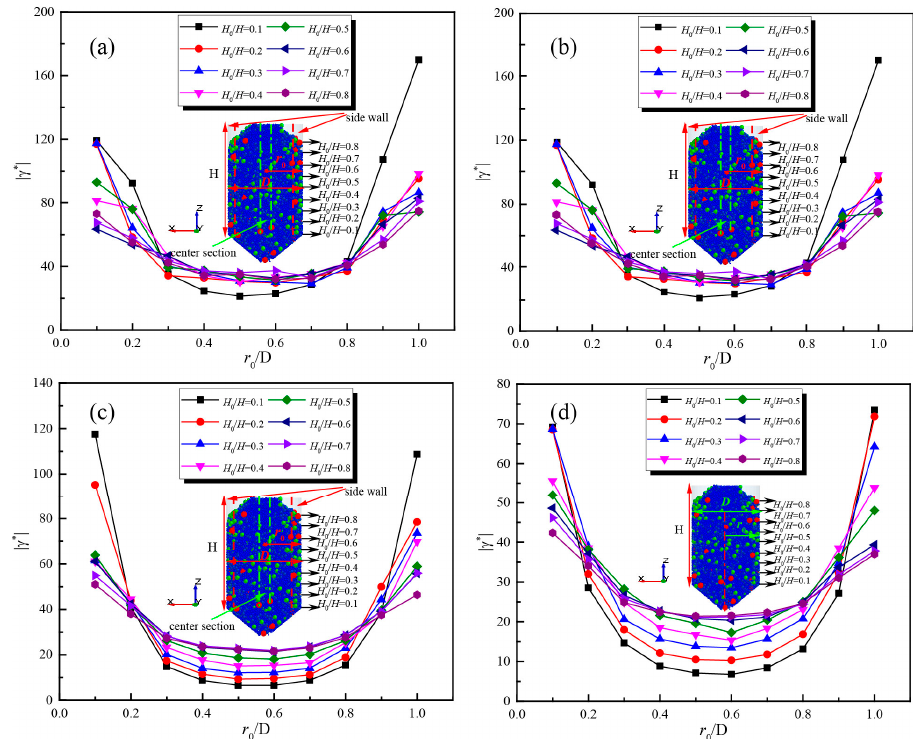
Figure 33. The variation in the shear rate of the sinter layers with variations in the discharge velocity. ( a ) v a = 0.1 m · s − 1 , ( b ) v a = 0.2 m · s − 1 , ( c ) v a = 0.3 m · s − 1 , and ( d ) v a = 0.4 m · s − 1